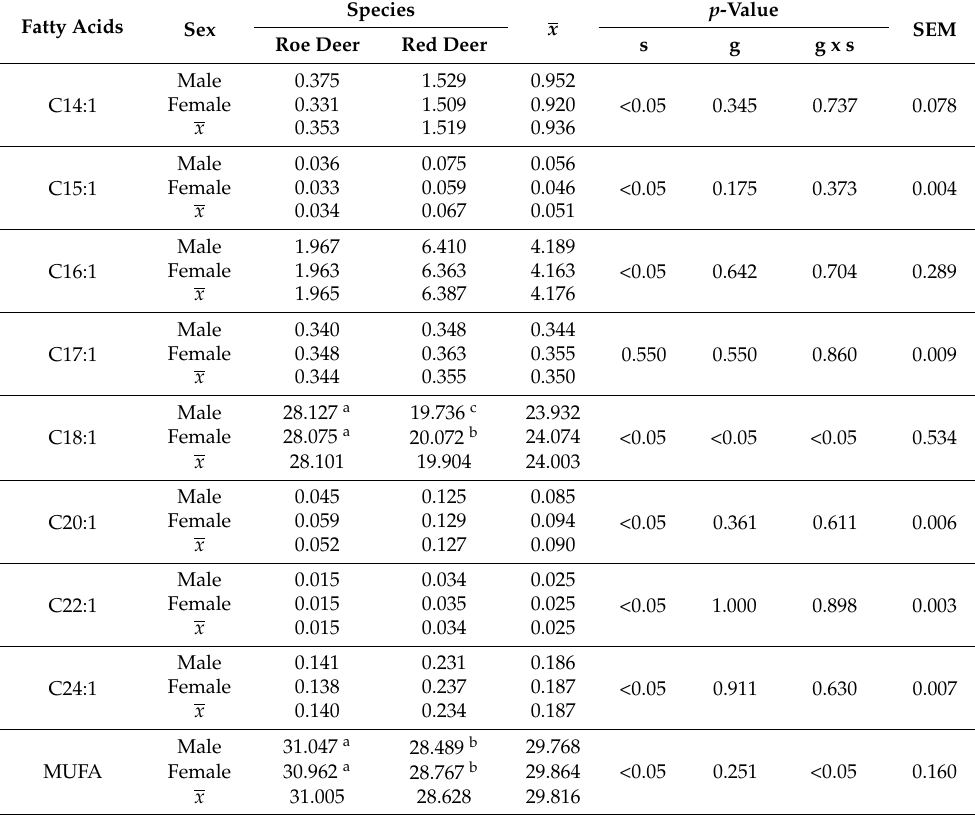
Table 4. Monounsaturated fatty acids profile (% total) of